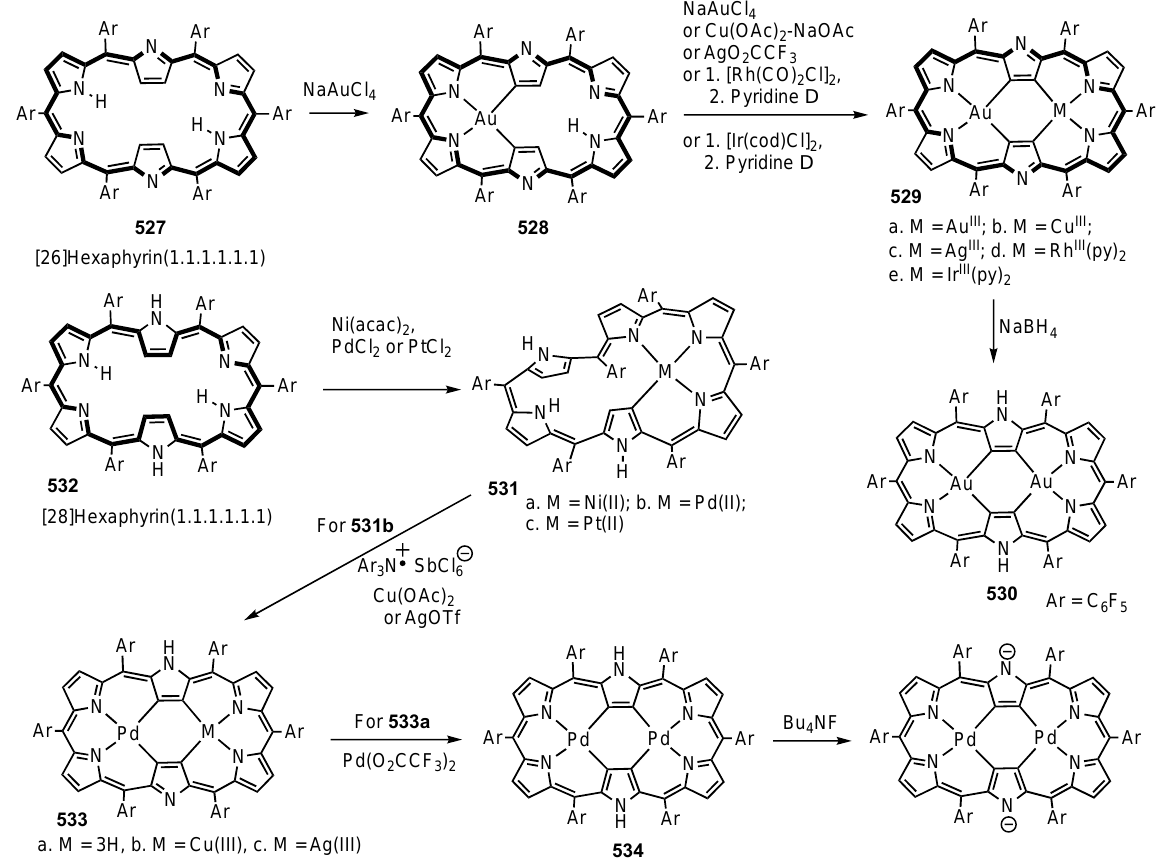
Scheme 80. Organometallic derivatives of hexaphyrins(1.1.1.1.1.1). Reaction of AuCl.SMe 2 with doubly N-confused hexaphyrin 535 gave the gold(III) complex 536 , and further treatment with PtCl 2 (PhCN) 2 afforded the mixed Pt(II)-Au(III) complex 537 (Scheme 81) [338]. In another intriguing study, reaction of palladium(II) acetate with dipyrihexaphyrin 538 gave three dipalladium complexes 538a,b and 539 (Scheme 82) [339]. Structure 539 is not an organometallic derivative but has an unusual interlocked structure with two pyricorrole-like components. Many examples of expanded porphyrins with m -phenylene or p -phenylene units have been described and these may also give organometallic derivatives. For example, dibenzihexaphyrin 540 reacted with Scheme 81. Organometallic derivatives of doubly N-confused hexaphyrins. palladium(II) chloride and potassium carbonate to give Möbius aromatic palladium(II) complex 541 (Scheme 83) [340]. Other examples include the Möbius aromatic palladium(II) porphyrinoids 542 and 543 (Figure 14) [341]. These examples illustrate some exciting examples of organometallic expanded porphyrinoids, but no attempt has been made to give comprehensive coverage of this